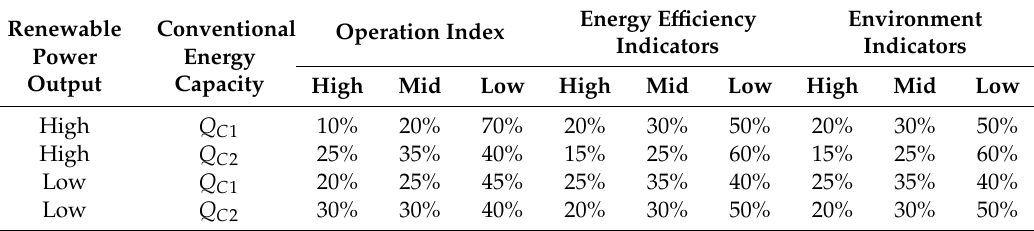
Table 6. The target probability distribution in the second stage of decision making under high load fluctuation.